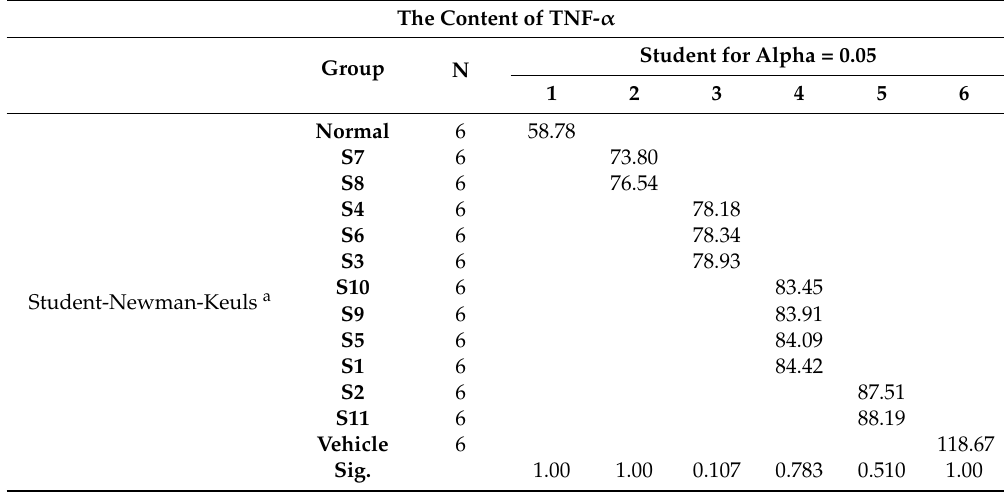
Table 4. Multiple comparison SNK test results of TNF- α ( a : Alpha).